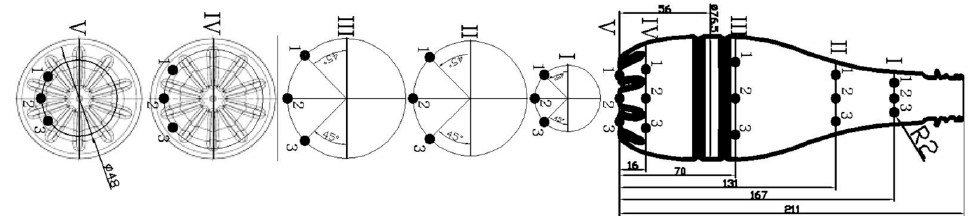
Figure 5. The shape of the analyzed bottle and the location of individual measuring points of the bottle wall thickness, also showing the area of thickness measurements around the measuring points for the example of point I-3 (explanation in Figure A1). The determination of the axial position of the point will be explained in the second part of this article.